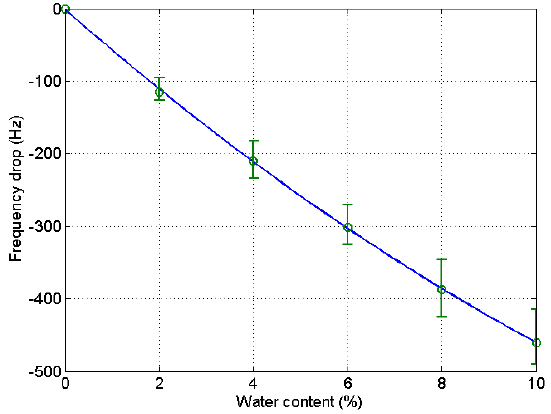
Figure 4. Relationship between water content and resonant frequency shift of bare quartz crystal microbalances in batch measurement.